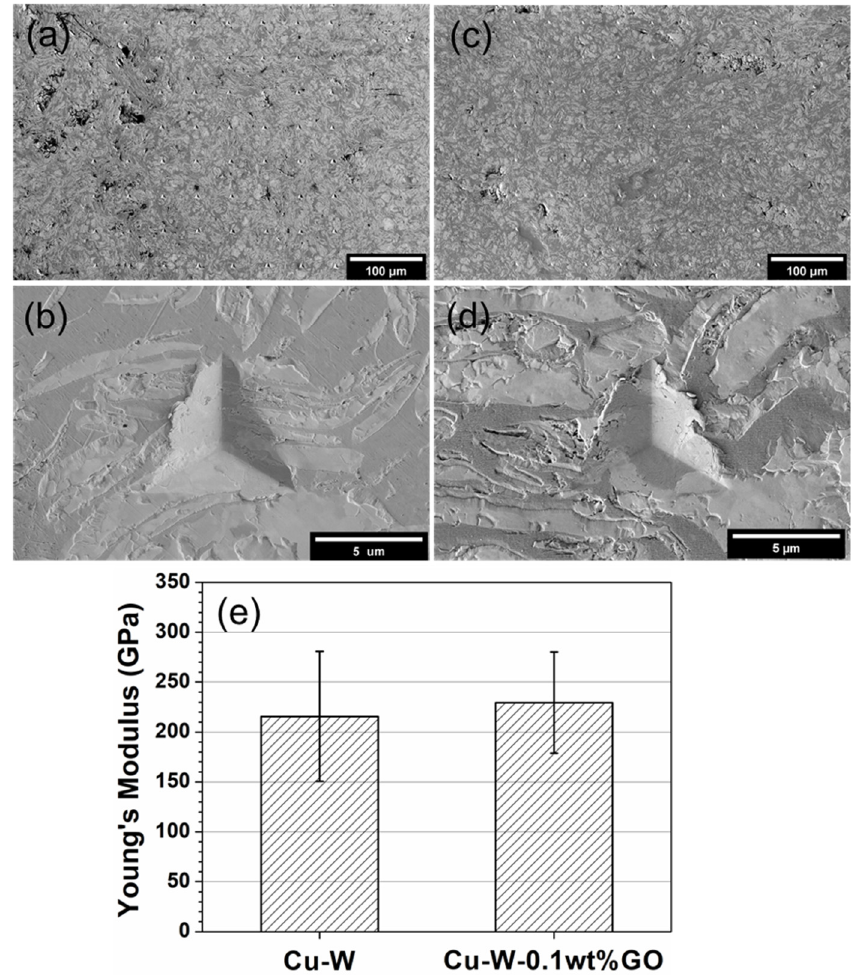
Figure 7. SEM image for the ( a ) Cu-W sample showing the whole indented area, and ( b ) one selected indent; SEM image for the ( c ) Cu-W-0.1 wt.% GO sample showing the whole indented area, and ( d ) one selected indent. ( e ) Values of the Young’s moduli of the Cu-W and Cu-W-0.1 wt.% GO